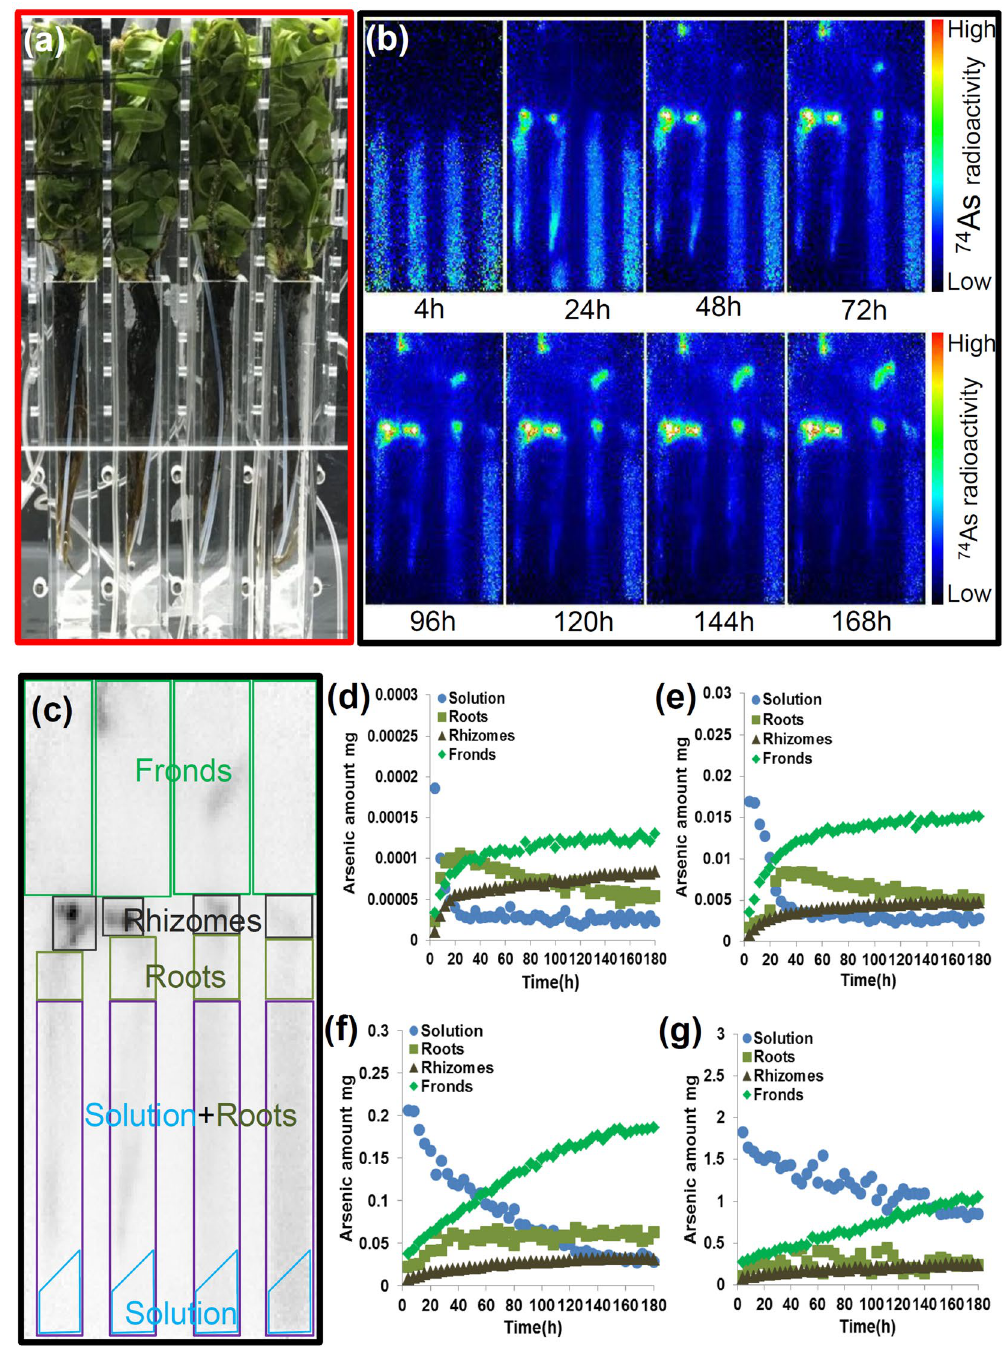
Figure 2. Serial images of 74 As behavior and time course of the amount of arsenic in different regions of P . vittata . ( a ) Photograph of test plants in the experimental apparatus. The solid red rectangles indicate the field of the PETIS imaging. ( b ) Serial images of P . vittata (0–168 h). Each frame was created from the integration of original images collected every 5 min. ( c ) Examined regions in the plants. The blue trapezoid indicates the region of the solution, the purple rectangle indicates the solution with the roots inside, the yellow-green rectangle indicates the roots above the solution, the black rectangle indicates the rhizomes and the green rectangle indicates the fronds. Time course of the amount of As in the regions shown in ( c ) fed with 0.2 μM AsV ( d ), fed with 20 μM AsV ( e ), fed with 200 μM AsV ( f ) and fed with 2000 μM AsV ( g ), all experiments included 2 kBq of 74 As-labeled